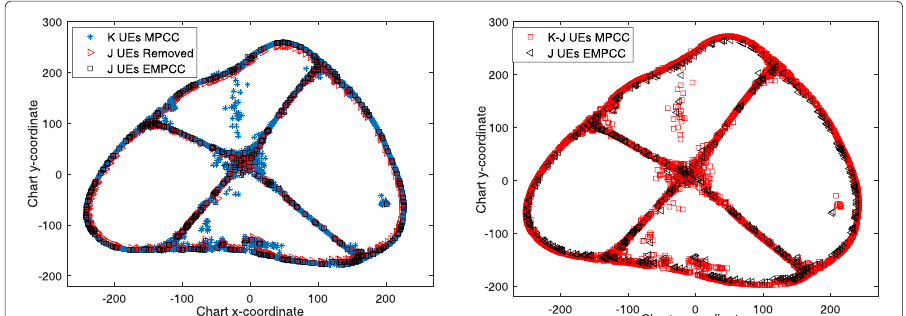
Fig. 8 Two-dimensional channel chart for 10 BSs. The channel chart location of out-of-sample UEs is in black color. Left: re-inserting removed sample. Right: inserting new